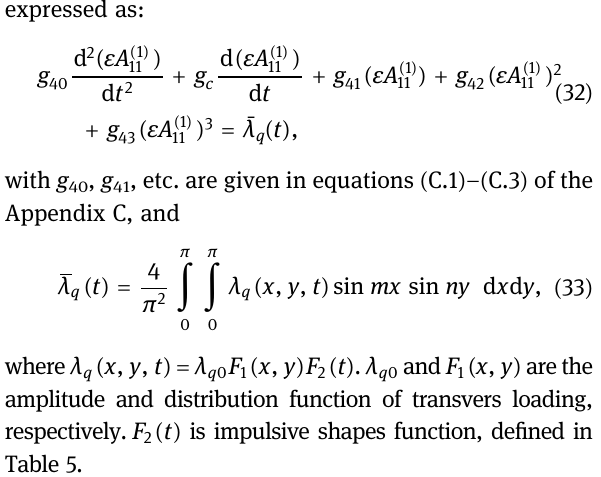
amplitude and distribution function of transvers loading,